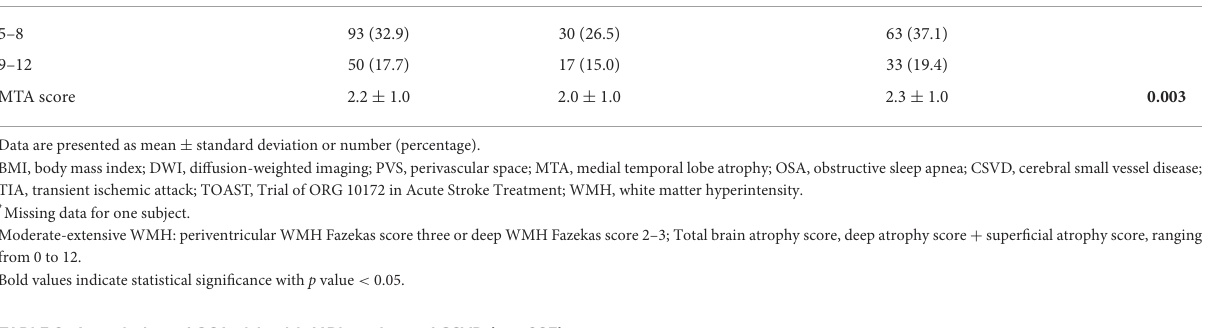
TABLE 2 Association of OSA-risk with MRI markers of CSVD ( n = 283). OSA-risk CSVD markers Outcome